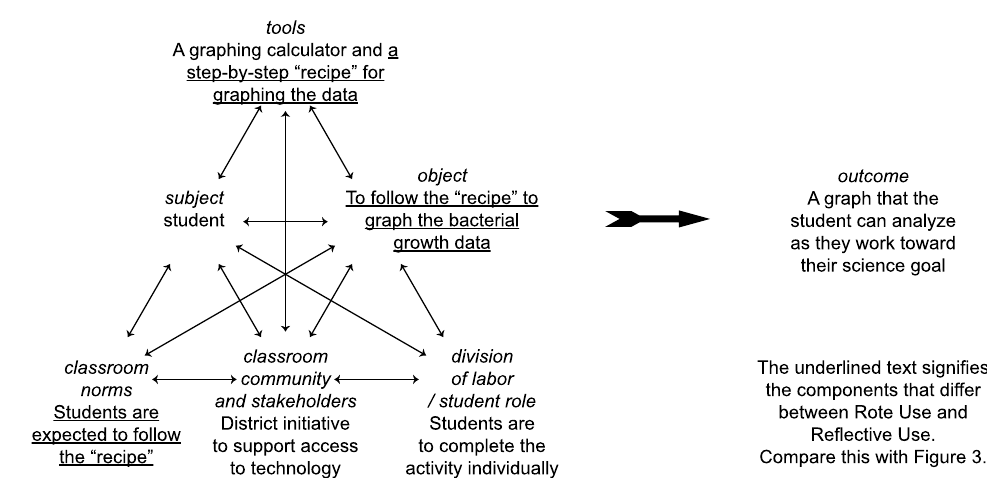
Fig. 4 Rote use of a computational tool for data processing activity